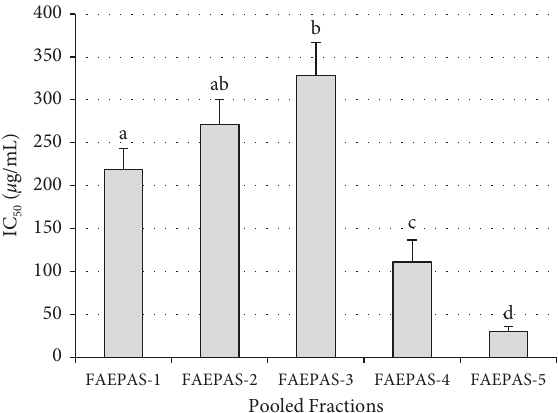
Figure 2: IC 50 of pooled fractions. NB: columns with different superscript alphabets are significantly ( p < 0 . 05) different from each